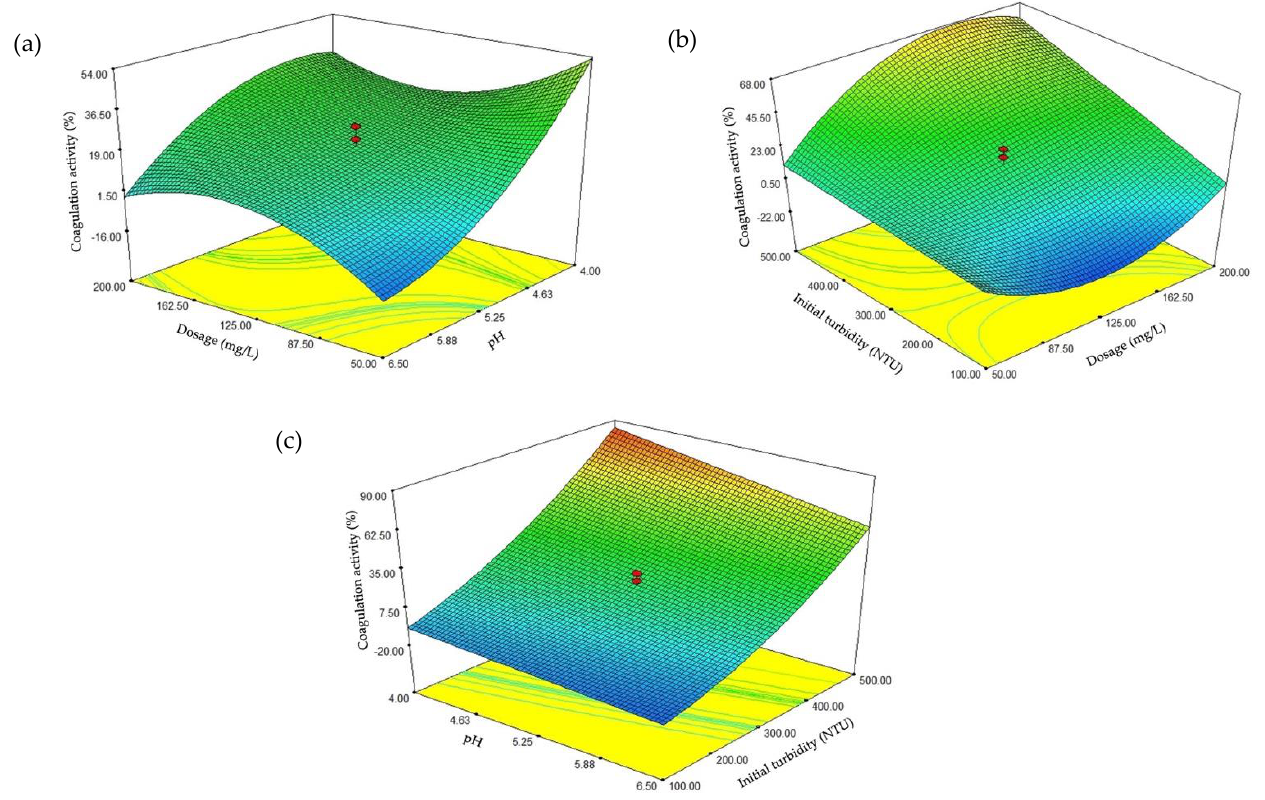
Figure 5. Response surface of the coagulation activity as a function of ( a ) deshelled Carica papaya seeds dosage and pH, ( b ) deshelled Carica papaya seeds dosage and initial turbidity and ( c ) pH and initial turbidity.